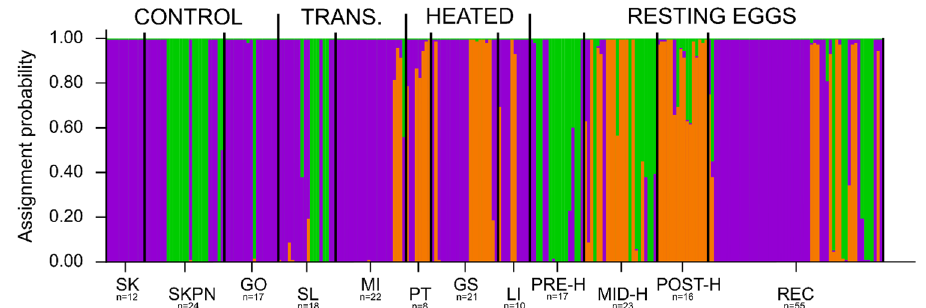
Figure 1. Plot of the assignment probability of contemporary samples and resting eggs to three genetically distinct clusters (different colours), inferred with STRU CTU RE based on microsatellite data. Individuals are grouped by lake of origin. Each vertical line (see Supplementary Fig. S4 online for an individual-based version of the plot) represents the assignment probability of one individual to three inferred clusters (purple, green, or orange). Contemporary samples are grouped as follows: three control lakes (SK, SKPN, GO), two transitional (TRANS.) heated lakes (SL, MI), and three heated lakes (PT, GS, LI). Resting eggs are grouped as follows: